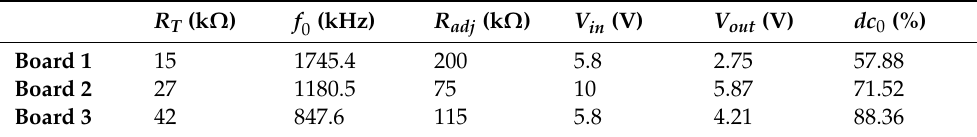
Table 4. Design parameters of the three boards.